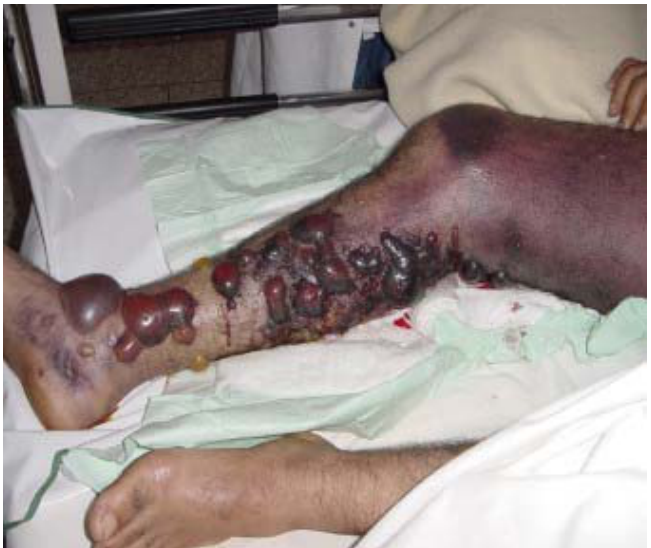
Figure 3. A 28-year-old patient admitted to the hospital after a snakebite in the region of Ouarzazate (south of